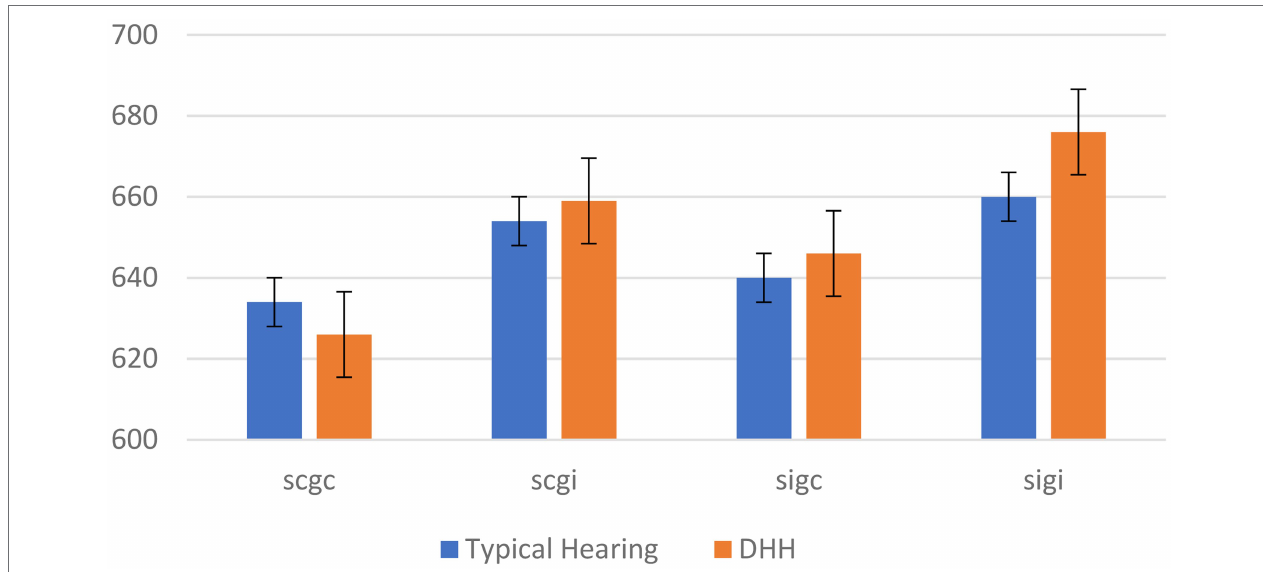
FIGURE 2 | RTs for semantic congruency and gender congruency between groups. scgc, semantic congruent and gender congruent; scgi, semantic congruent and gender incongruent; sigc, semantic incongruent and gender congruent; and sigi, semantic incongruent and gender